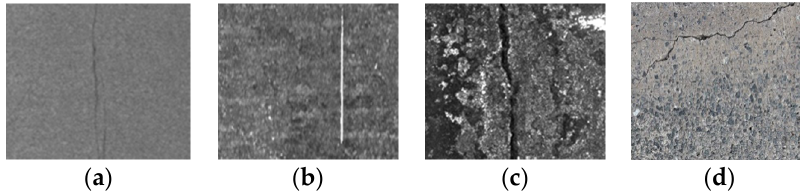
Figure 1. Statistical textures examples. ( a ) Hot-rolled steel strips surface, homogeneous; ( b ) Con- casting slabs surface, homogeneous; ( c ) Con-casting slabs surface, inhomogeneous; ( d ) Bridge deck inhomogeneous.